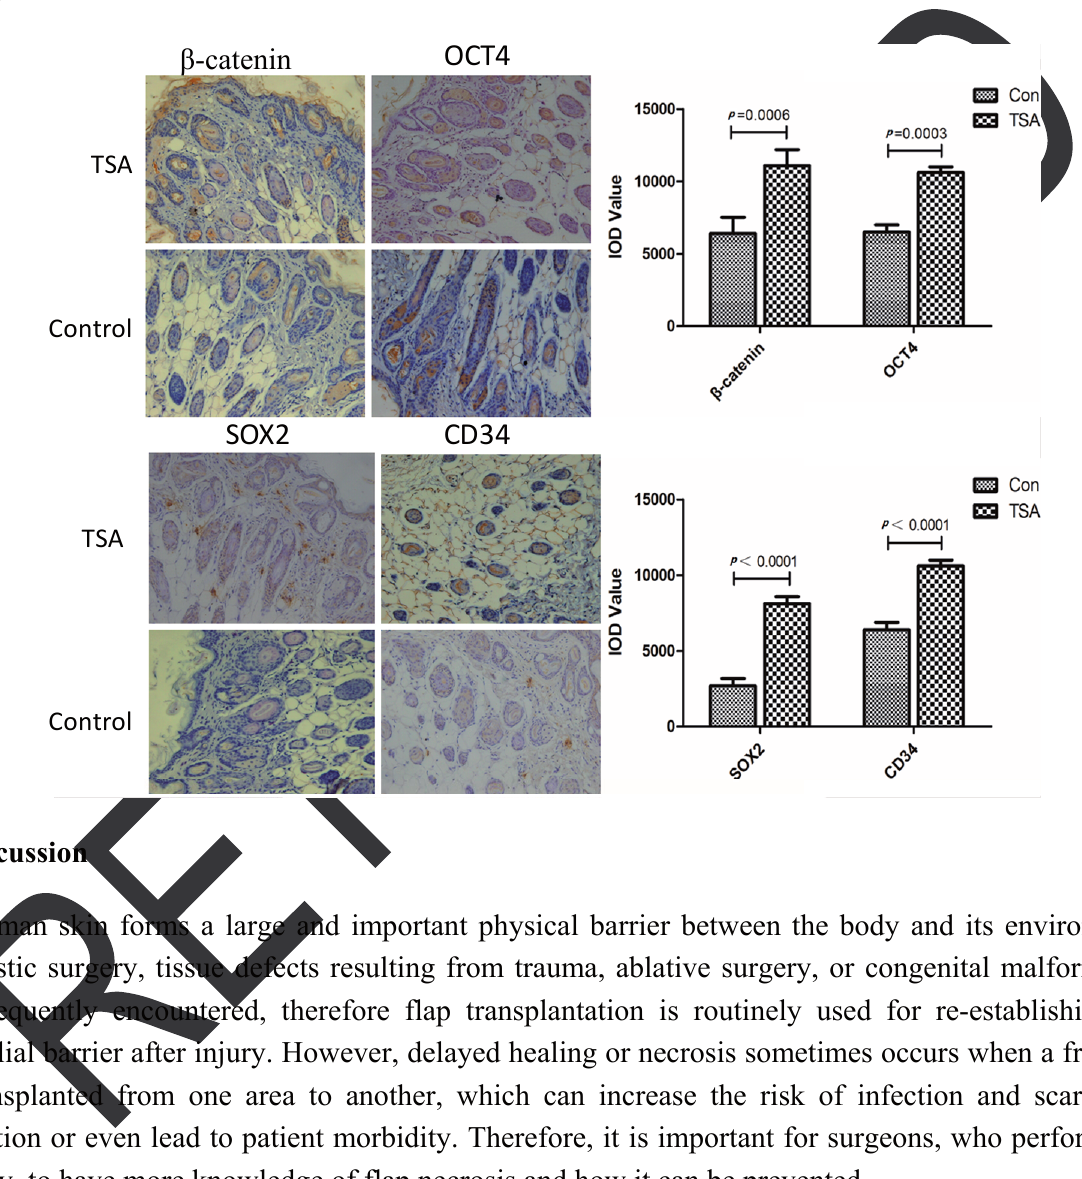
Figure 4. TSA pretreatment showed the up-regulated of β-catenin and the increased expression of stemness related markers, such as OCT4 and SOX2 in epithelial skin tissues. CD34 which is represented the microvessel density (MVD) was also raised after pretreatment with